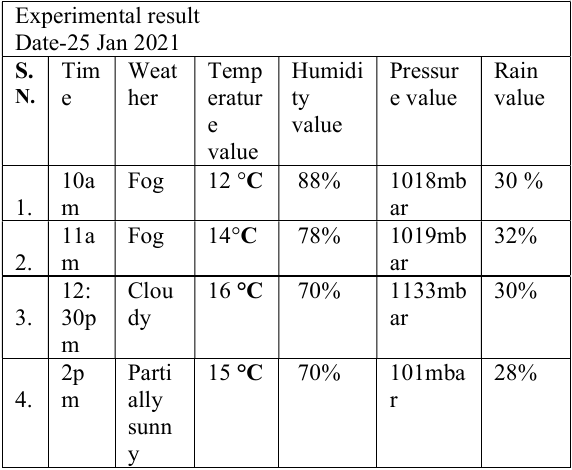
Table 7: Experimental reading obtained at Gorakhpur (MMMUT college) Experimental result